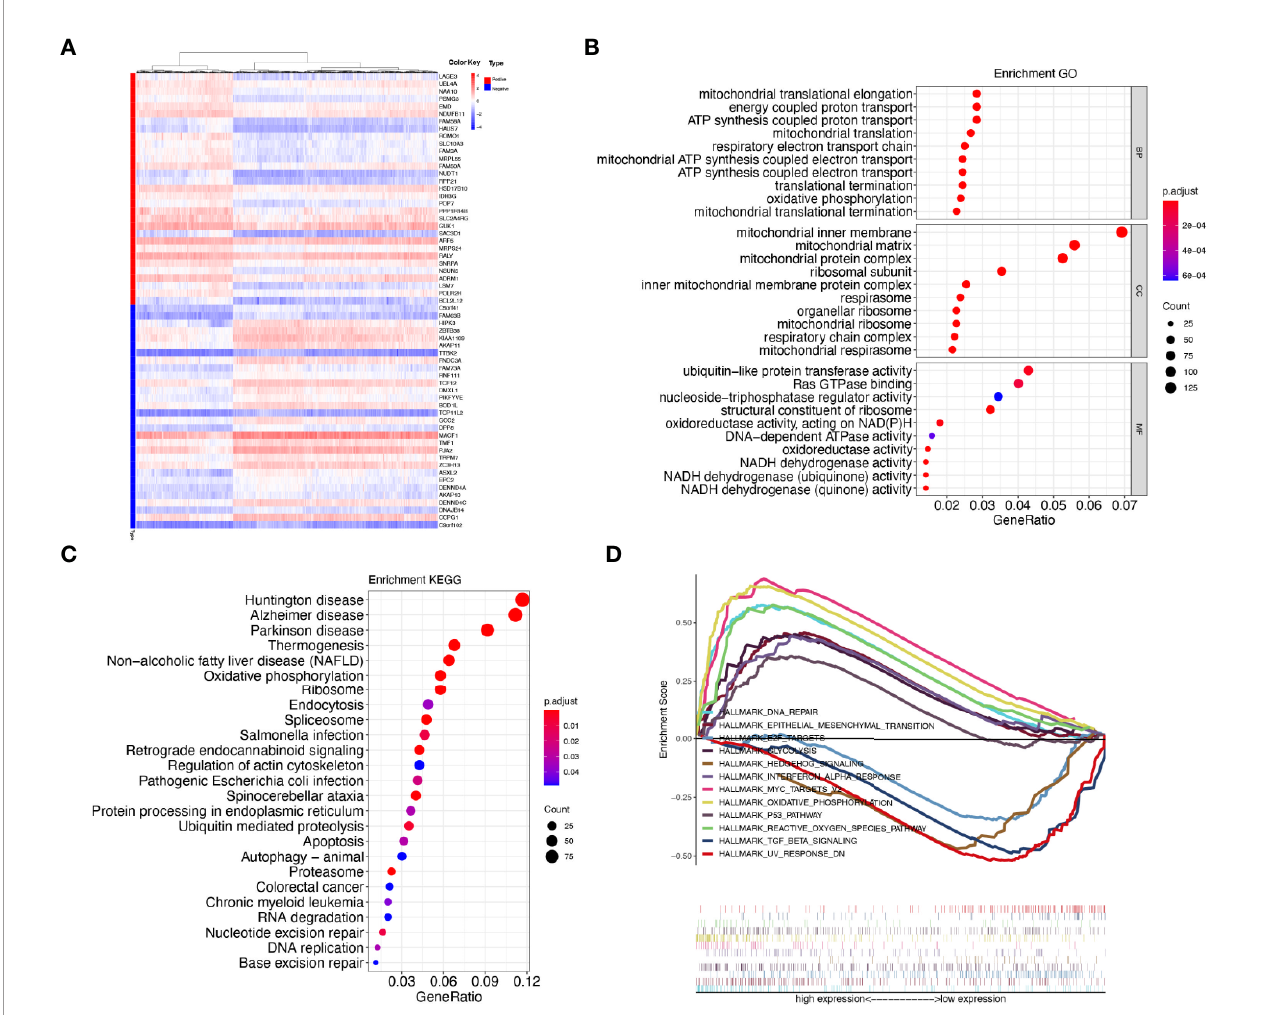
FIGURE 6 | LAGE3 co-expressed genes and functional enrichment analysis. (A) Heatmaps showing the top 30 genes positively and negatively correlated with LAGE3. (B) GO enrichment analysis (top 10 terms of each subtype) and (C) KEGG enrichment analysis based on genes co-expressed with LAGE3. (D) GSEA analyses displayed key pathways associated with LAGE3